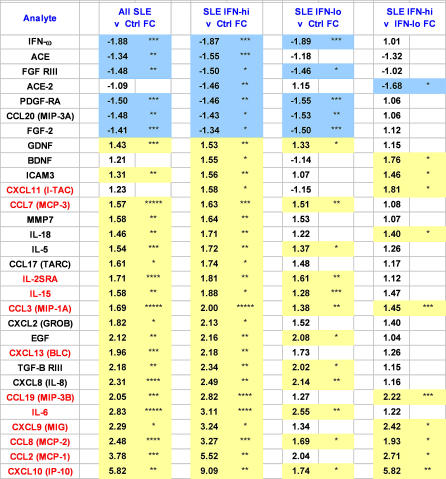
Thirty Protein Analytes Dysregulated in SLE SerumSera from 15 IFN-hi SLE, 15 IFN-lo SLE, and 15 controls were assayed for the presence of 160 protein analytes by antibody microarrays. CXCL10 (IP-10) was measured by Luminex bead immunoassays. Shown are 30 analytes that demonstrated significant differences in at least one inter-group comparison, using the following criteria: mean fold change (FC) ≥ 1.5, and p < 0.05 by unpaired t-test. Data are presented as mean fold change of the group comparisons. Analytes regulated by type I IFN, as determined by in vitro gene expression microarray experiments, are highlighted in red font. * p < 0.05; ** p < 0.01; *** p < 0.001; **** p < 0.0001; ***** p < 0.00001. Comparisons highlighted in yellow represent significant positive associations, and blue indicates significant negative associations. The levels of statistical significance shown represent nominal p-values and are not corrected for the multiple hypotheses tested. The results obtained when these p-values were corrected using the Benjamini-Hochberg adjustment for multiple testing are provided in Table S1.